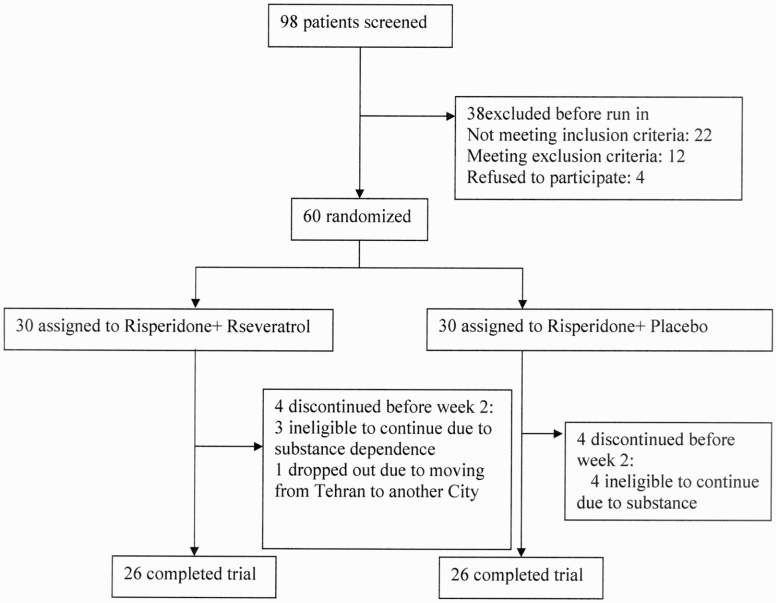
CONSORT flow diagram of the trial